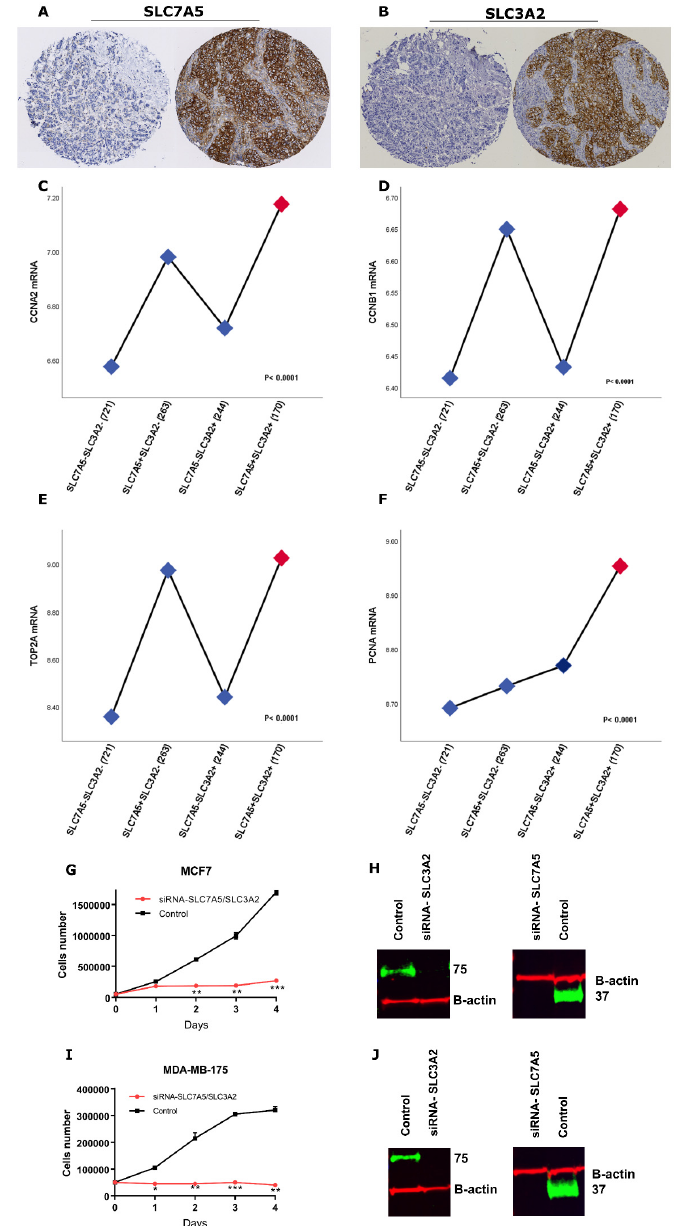
Figure 1. ( A ) Negative and positive SLC7A5 protein expression and ( B ) negative and positive SLC3A2 protein expression in invasive breast cancer cores using IHC. Association of SLC7A5 / SLC3A2 mRNA co-expression with proliferation associated-genes, including ( C ) CCNA2 , ( D ) CCNB1 , ( E ) TOP2A and ( F ) PCNA , using the METABRIC cohort. A one-way ANOVA with the post-hoc Tukey multiple comparison test was used, and p values of ≤ 0.05 were considered significant. ( G ) MCF-7 and ( I ) MDA-MB-175-VII cells were transfected with control siRNA or SLC7A5 and SLC3A2 siRNA (si-SLC7A5 / SLC3A2) for 24 h. Cells were then seeded in duplicate in corresponding media, and on the indicated days, cells were trypsinized and stained with trypan-blue and counted. Results shown are mean ± SE of two independent experiments. Asterisks denote p -values as follows: * p < 0.05; ** p < 0.005; *** p < 0.001. The e ffi ciency of SLC7A5 and SLC3A2 knockdown in ( H ) MCF7 and ( J ) MDA-MB-175-VII cells were confirmed by Western